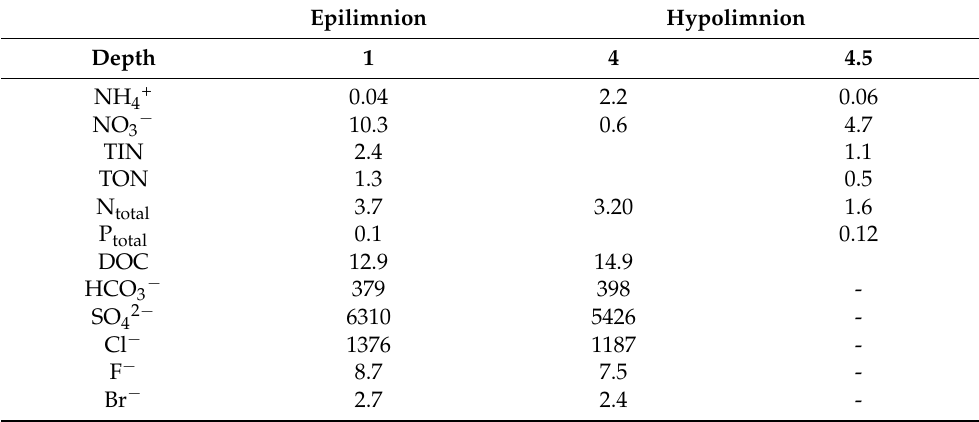
Table 1. Chemical and limnological values from water samples from Lake Alboraj in sampling campaign. Depth is given in meters and concentration of ions, in mg/L. -: no data available. Epilimnion Hypolimnion Depth 1